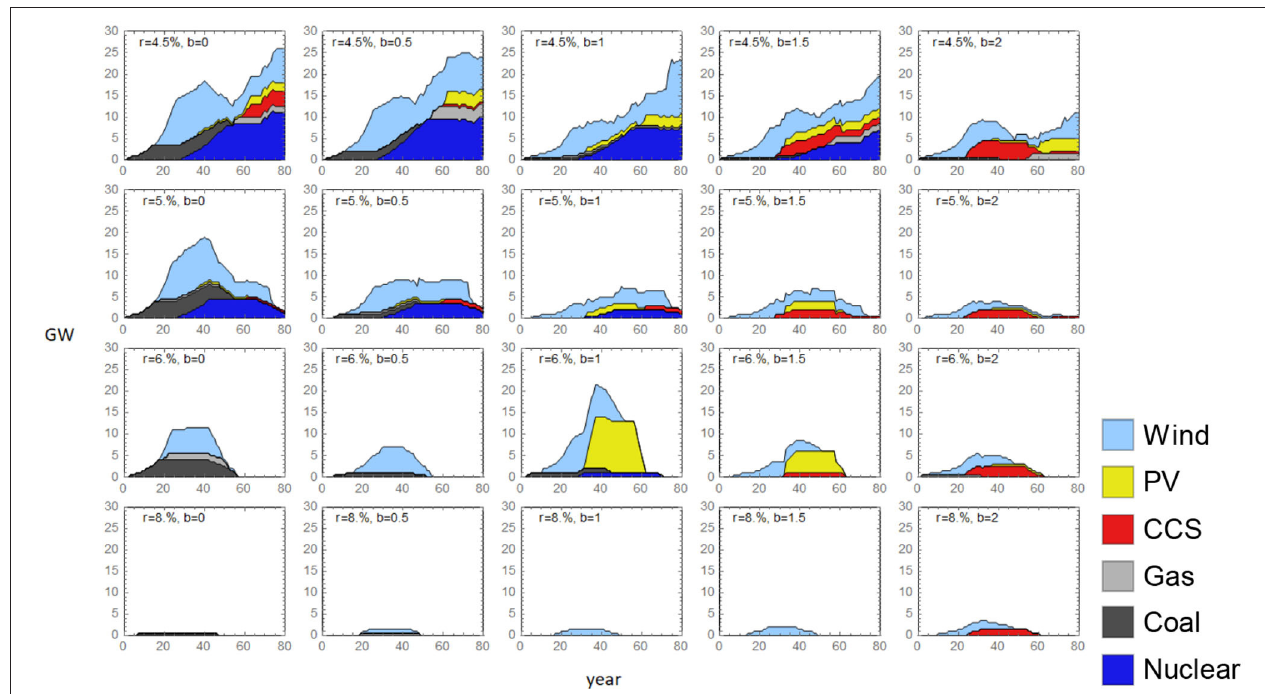
FIGURE 4 | Installed capacity of 20 individual agents in the base case [ f = 30% and i = 400M e . f is the fraction of an investment financed by a company’s own capital and i is the initial capital in a company’s bank account]. r is the hurdle rate agents use and b is the expected carbon tax parameter.